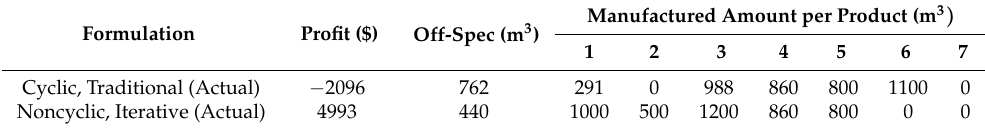
Table 22. Economic results: Scenario 3.